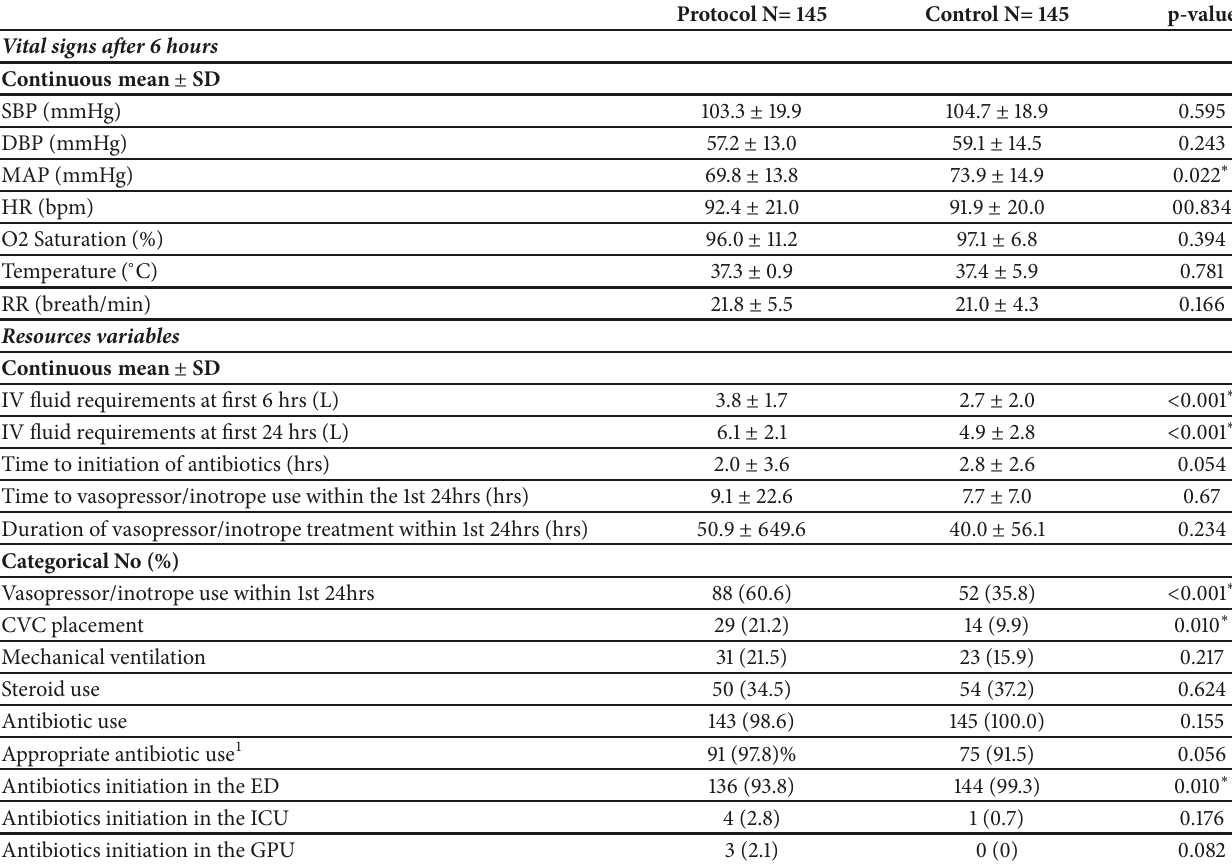
Table 3: Resuscitation parameters.